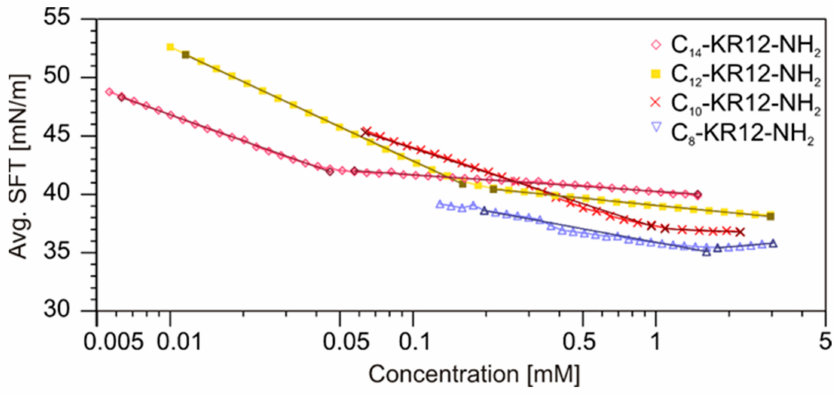
Figure 7. Relationship between the surface tension and peptide